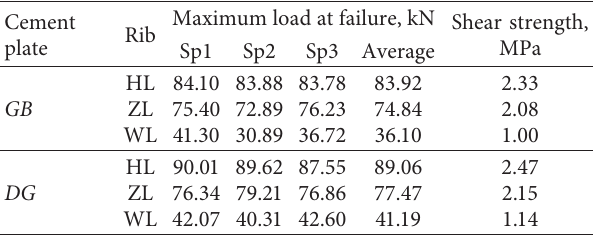
Table 9: Maximum load at failure and the shear strength of the interface for composite samples with different ribs.